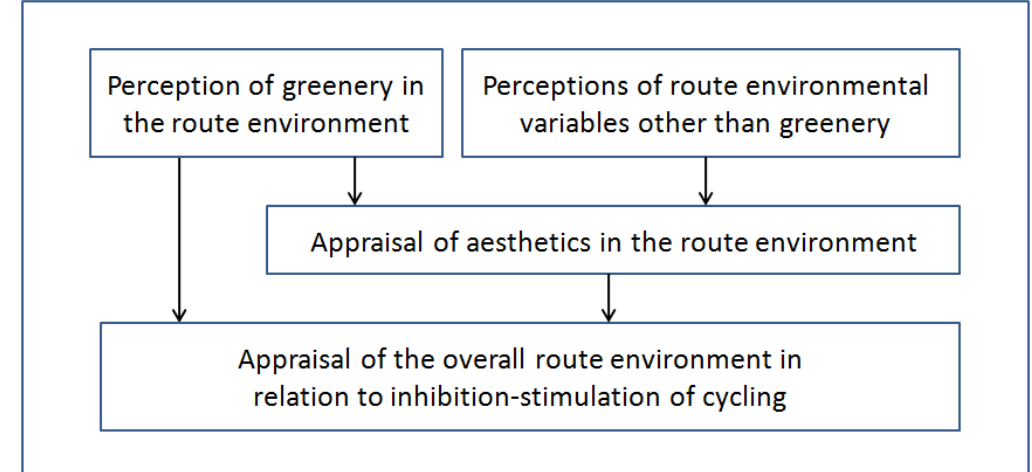
Figure 3. Model of relations between greenery, aesthetics and stimulation of cycling in route environments. The model illustrates that perceptions of greenery (ACRES predictor variable: greenery ) may affect the overall appraisal of route environments (ACRES outcome variable: hinders or stimulates ) in two ways: independently and via the appraisal of aesthetics (ACRES predictor: ugly or beautiful ). In addition, the model illustrates that other environmental sources than greenery, such as architecture, water and open spaces, affect the appraisal of aesthetics. The model is modified from reference